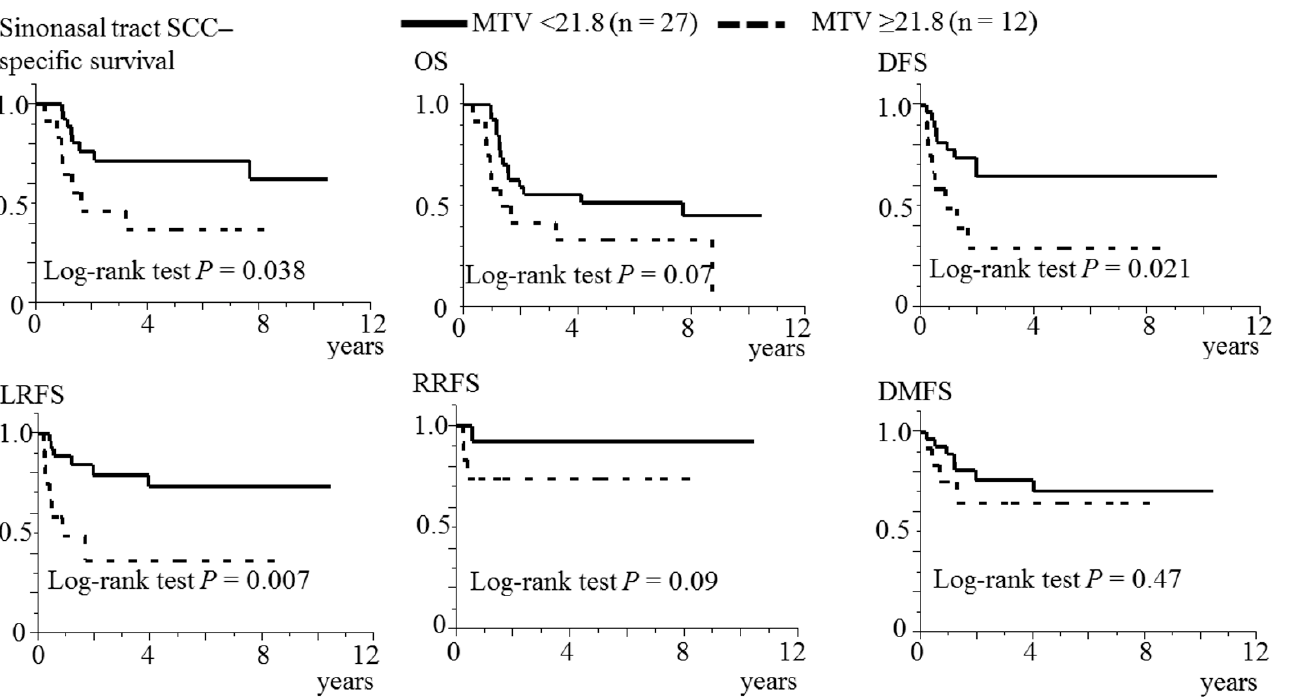
Figure 3. Association between MTV and the survival in 39 patients. MTV, metabolic tumour volume; SCC, squamous cell carcinoma; OS, overall survival; DFS, disease-free survival; local recurrence-free survival; RRFS, regional recurrence-free survival; DMFS, distant metastasis-free survival. Table 2 shows no relationships between MTV and clinical parameters. Table 2. Association between MTV and clinical characteristics in 39